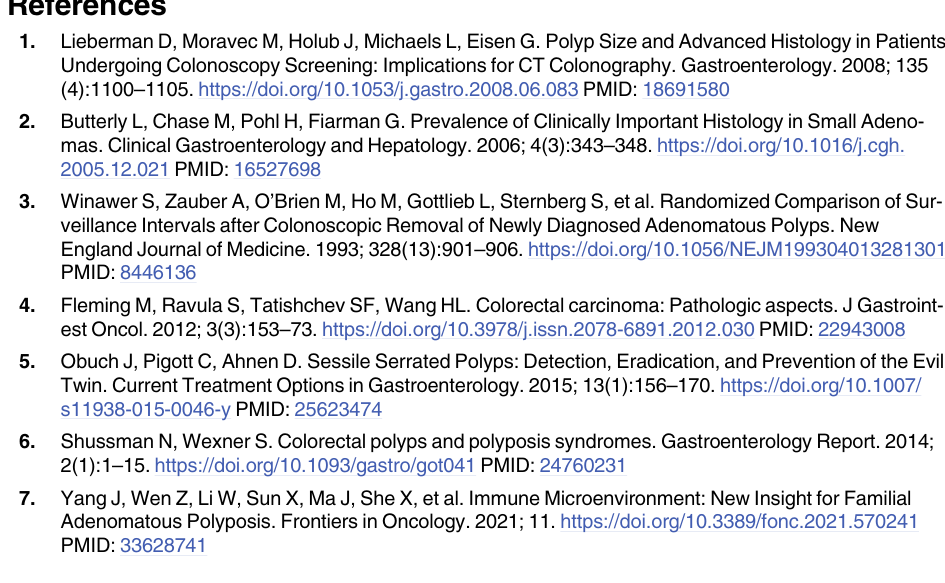
S1 Table. Comparison of GSE37364 in validation set and significant submodules in train- ing set. S2 Table. Comparison of GSE68468 in validation set and significant submodules in train- ing